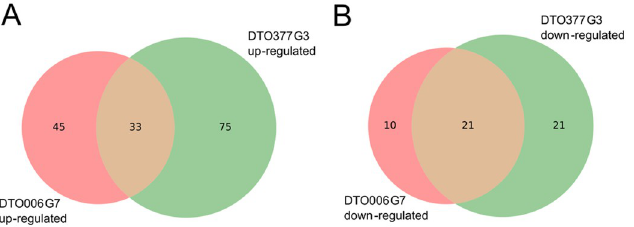
Fig 7. Venn diagram of differentially expressed genes in the presence of sorbic acid. Up- (A) or down-regulated (B) in R-type DTO006G7 and S-type DTO377G3 when exposed to sorbic acid compared to the control in the absence of this weak acid. Genes were considered up- or down-regulated when the log 2 FC > 2, p-value < 0.05 and FPKM > 10.